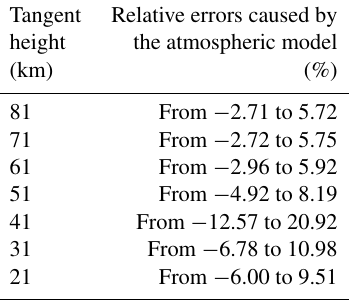
Table 6. Relative errors in OH fluorescence emission radiance caused by the atmospheric model at some tangent heights. Tangent